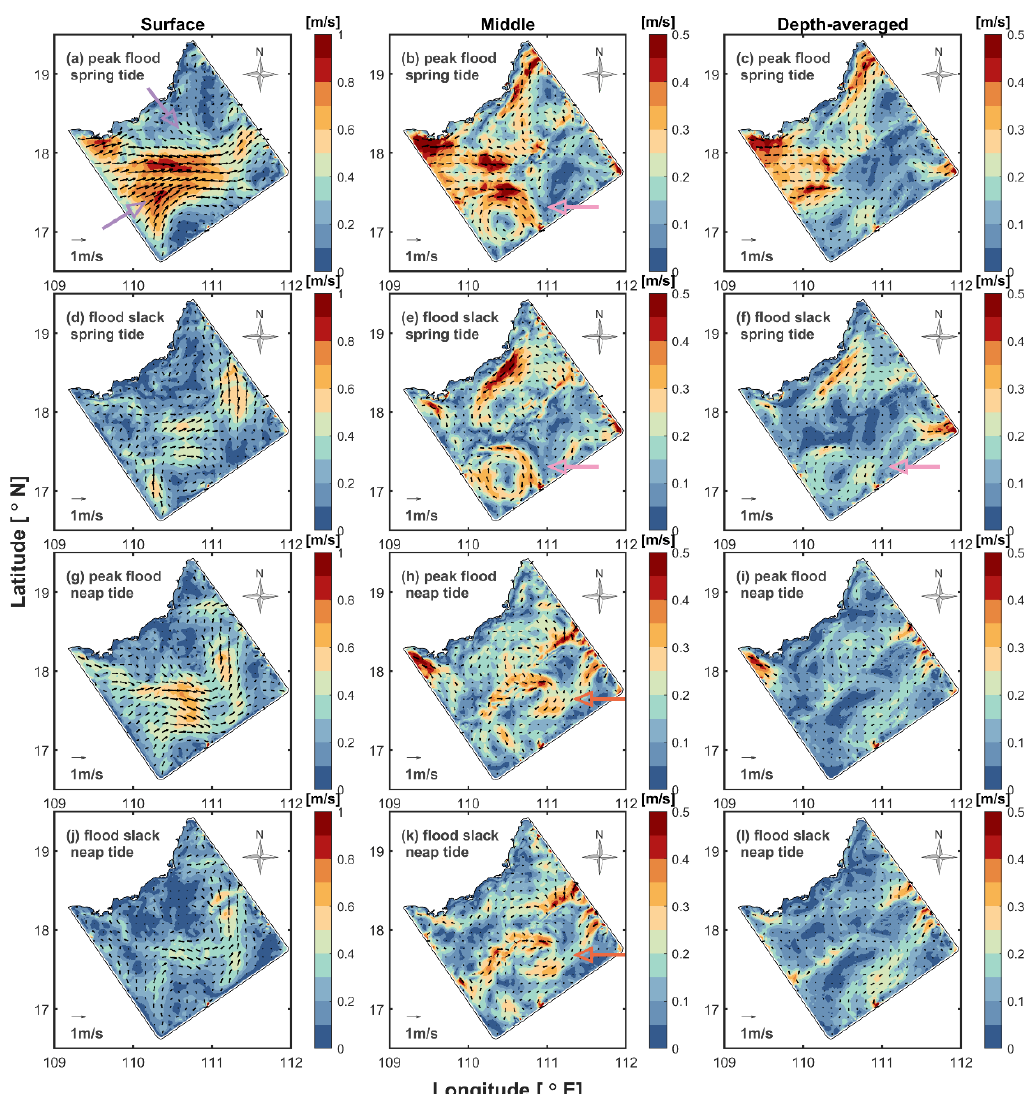
Figure 4. Flow field at different times and different layers. ( a – c ) Peak flood of the spring tide. ( d – f ) Flood slack of the spring tide. ( g – i ) Peak flood of the neap tide. ( j – l ) Flood slack of the neap tide. ( a , d , g , j ) Sea surface flow field. ( b , e , h , k ) Middle layer flow field. ( c , f , i , l ) Depth-averaged flow field.